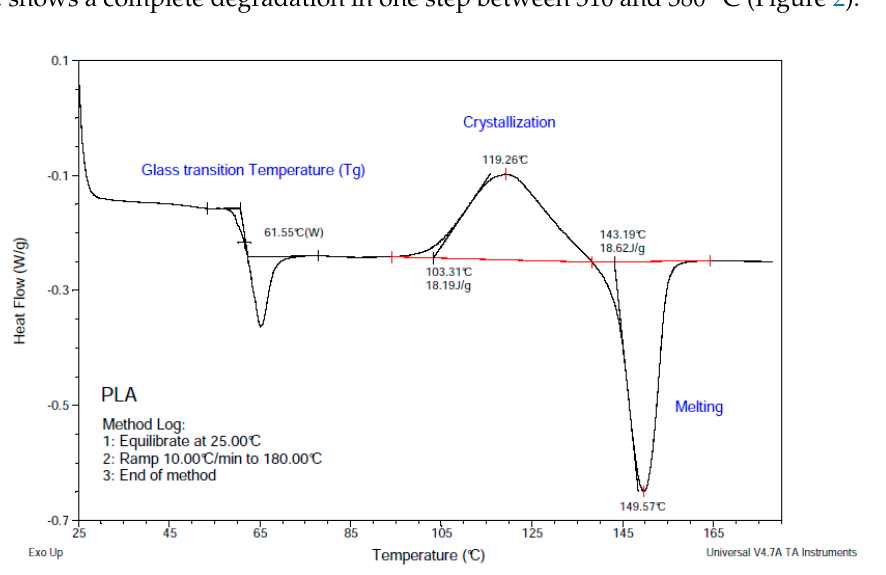
Figure 1. DSC curve of poly(lactic acid) (PLA).